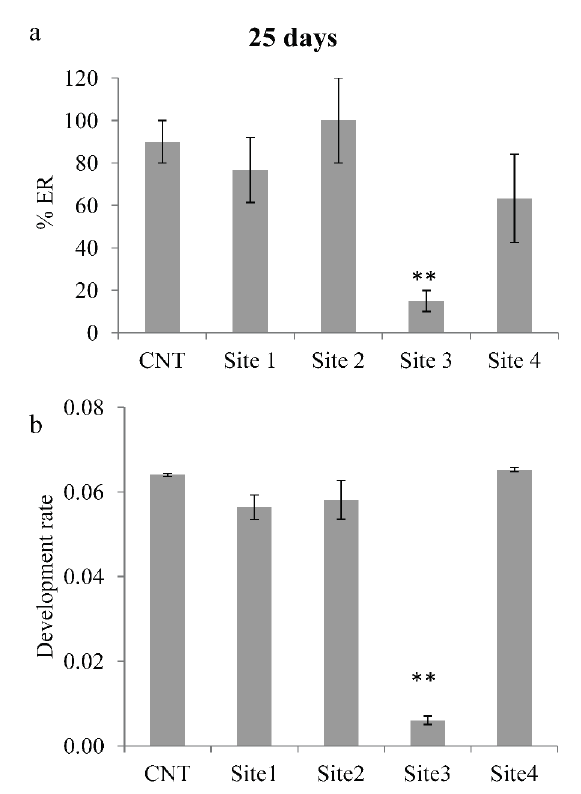
Figure 4. 25-days chironomids exposure test. ( a ) The emergence ratio (ER ± SD) of chironomid midges for each site and the control (CNT); ( b ) the development rate (DR ± SD) . Significant differences (one-way ANOVA, Dunnett’s post hoc test; p < 0.005 **) from the control are